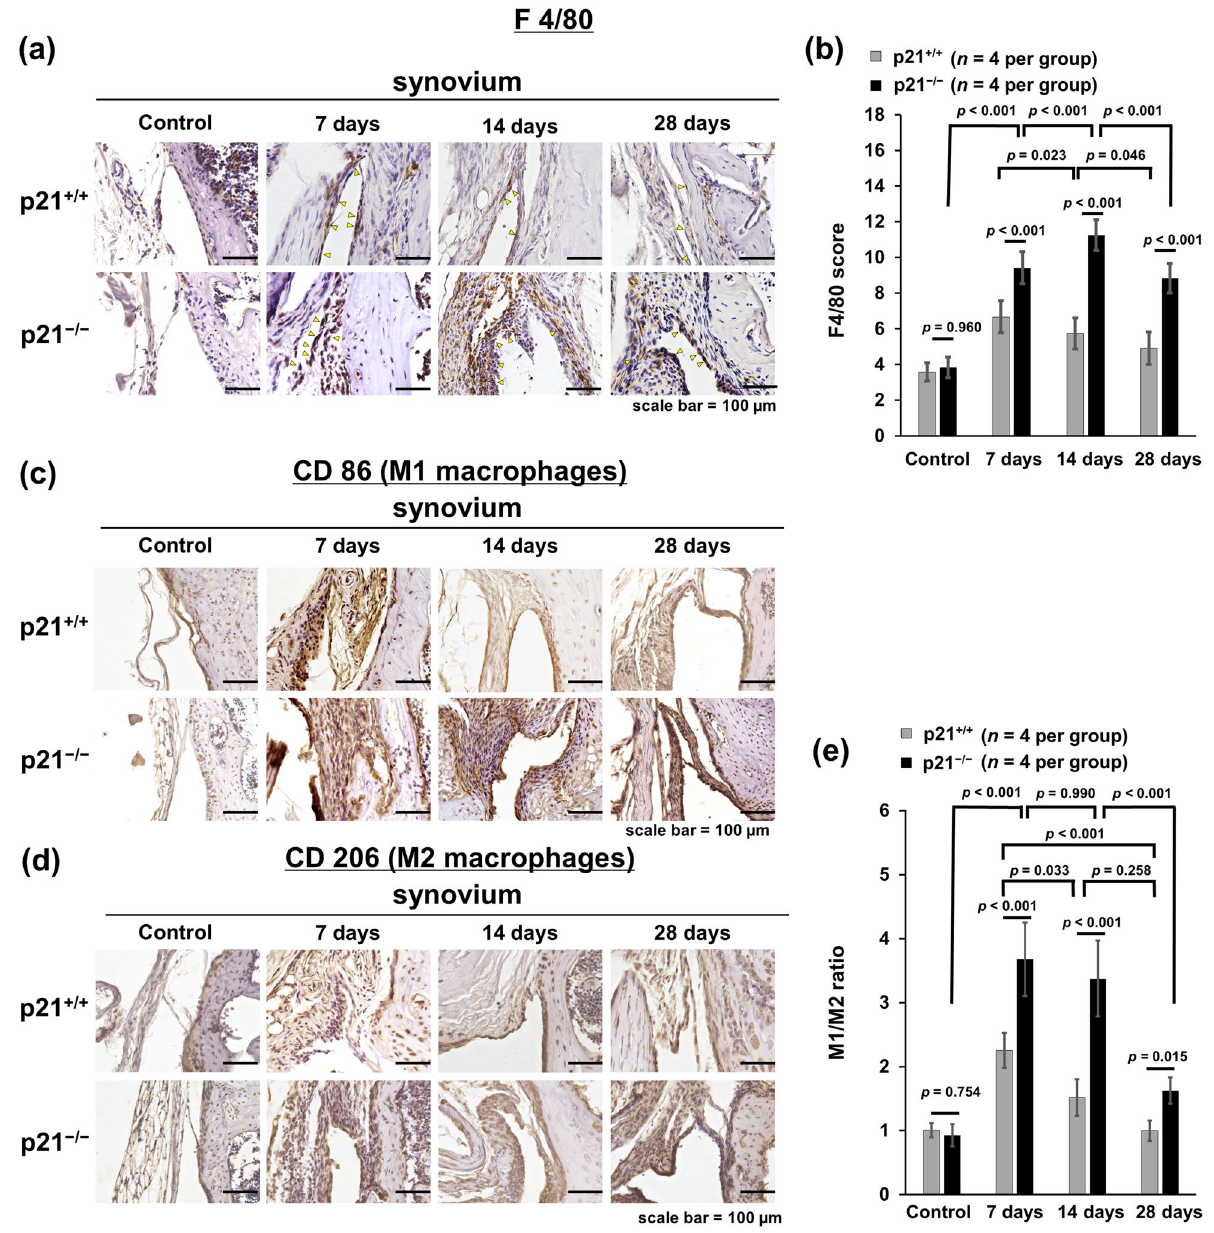
Figure 3. p21 levels influence the number of F4/80- and CD 86-positive cells in the CAIA mouse model. ( a,c,d ) Synovial tissue samples were collected from the knees of mice after antibody cocktail administration. ( a,c,d ) p21 +/+ mice and p21 −/− mice as control, on days 7, 14, and 28. ( b ) Semiquantitative analysis of the infiltration of F4/80-positive cells into the synovial membrane. The average F4/80 score with 95% CI was calculated from all four quadrants. The sections were counterstained with hematoxylin ( e ) The CD86/CD206 expression ratio (M1/ M2 ratio) with 95% CI. The sections were counterstained with hematoxylin. In ( b,e ), four mice were analyzed from each group. Two-way analysis of variance and Tukey’s post hoc test for multiple comparisons of paired samples were used. CI confidence interval, CAIA collagen antibody-induced arthritis, p21 cyclin-dependent kinase inhibitor